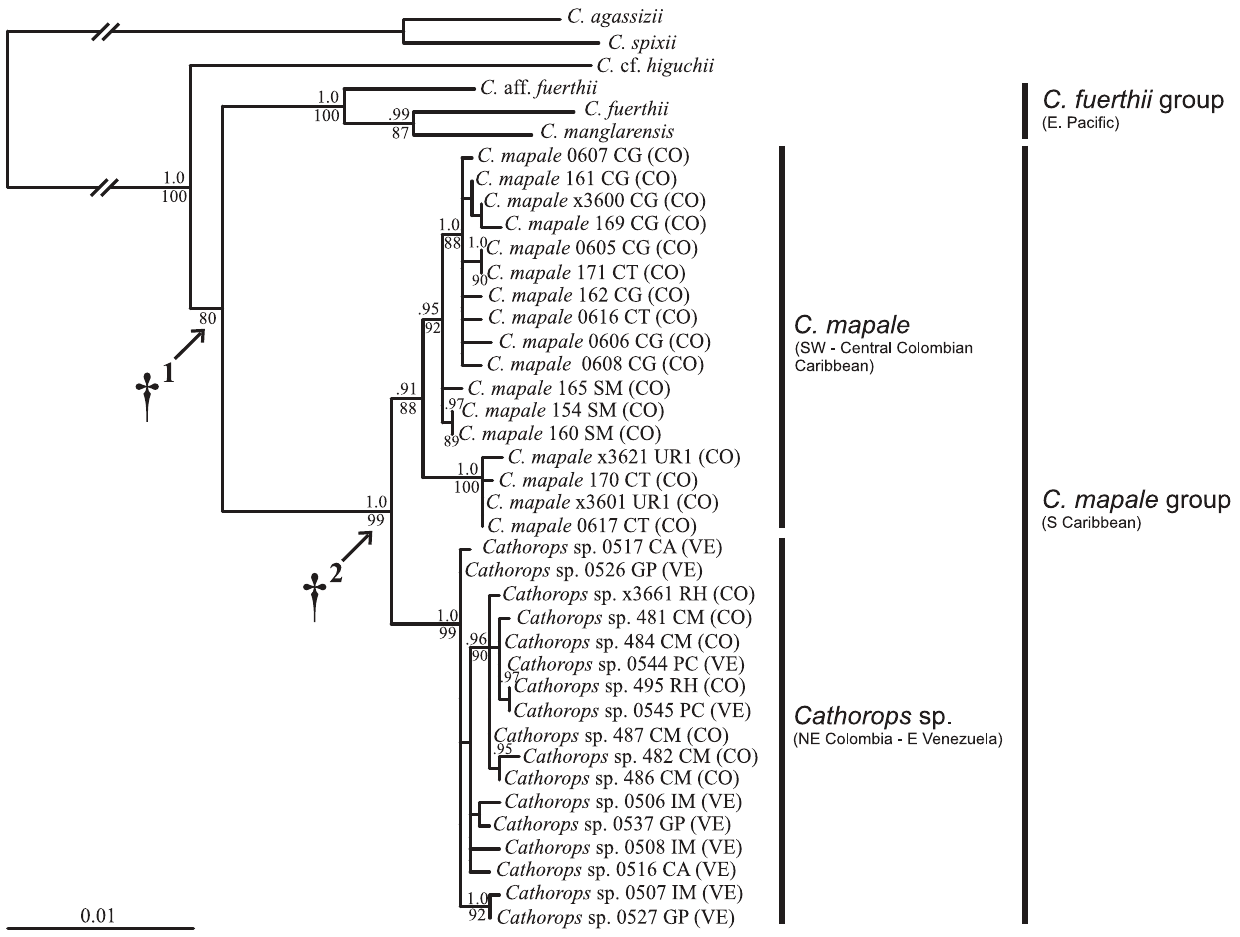
Figure 2. Phylogenetic hypothesis for the Cathoropsmapale group and related species inferred from mitochondrial sequences ( , 2 kbp). Phylogram shown was estimated from ML analyses (lnL -4686.70); well-supported clades are congruent with MP and BI topologies (outgroup Cathorops hypophthalmus not shown). Numbers below and above nodes represent RAxML bootstrap values (300 replicates via automatic estimation of runs) and Bayesian posterior probabilities, respectively (well-supported clades only). { 1 Molecular clock calibration point: Pliocene rising of Panama isthmus. { 2 Molecular clock estimation point for testing the hypothetical vicariant event separating Cathorops sp. and C. mapale : northward displacement of Santa Marta Massif and disruption of continental shelf (end of early Pleistocene). Locality abbreviations follow Fig. 1 and Table S1 (ISO-3166 country codes given in parenthesis).